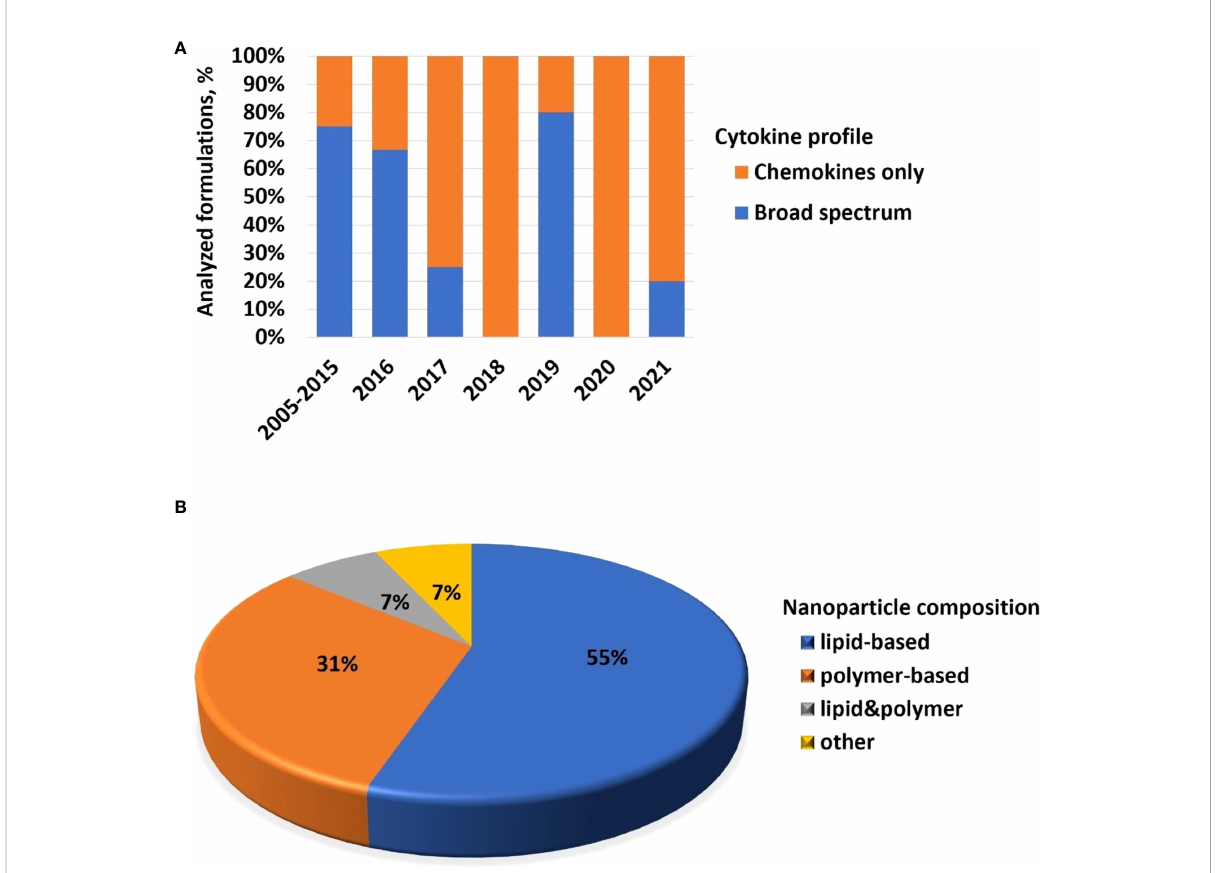
FIGURE 4 NCL assay cascade experience with cytokine analysis. Between 2005 and 2021, NCL has characterized over 450 nanotechnology formulations using assay cascade protocols (https://ncl.cancer.gov/resources/assay-cascade-protocols) that include six assays for the assessment of cytokines (ITA-10, ITA-22, ITA-23, ITA-24, ITA-25, and ITA-27). (A) Breakdown of formulations by cytokine pro fi le (i.e., formulations that induced broad-spectrum cytokines versus those that exclusively induced chemokines). Percentage re fl ects the total number of formulations subjected to cytokine analysis. The data for 2005 – 2015 are pooled; during this time, IL-8 was the only chemokine on the NCL cytokine panel; other cytokines in the NCL 2005 – 2015 panel include TNF, IL-1 b , IL-6, and IFN l . The panel was expanded and, since 2016, includes chemokines MIP- 1 a , MIP-1 b , MCP-1, MCP-2, and RANTES, in addition to the IL-8. Other cytokines in the extended panel are TNF, IL-1 a , IL-1 b , IL-2, IL-4, IL-5, IL- 6, IL-7, IL-10, IL-12, IL-13, IL-15, IL-17, IL-22, IL-23, IL-27, IFN g , IFN a , IFN b , and IFN l . “ Broad-spectrum ” refers to all or any combination of